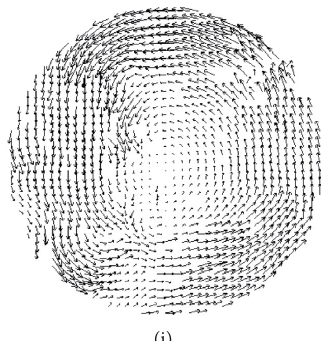
Figure 16: Earlier stage of the loading period. (a) Stress distribution (entire model). (b) Stress distribution (vertical section). (c) Stress distribution (transversesection). (d) Contactdistribution (entiremodel). (e)Contact distribution (verticalsection).(f) Contact distribution(transverse section). (g) Displacement field (entire model). (h) Displacement field (vertical section). (i) Displacement field (transverse